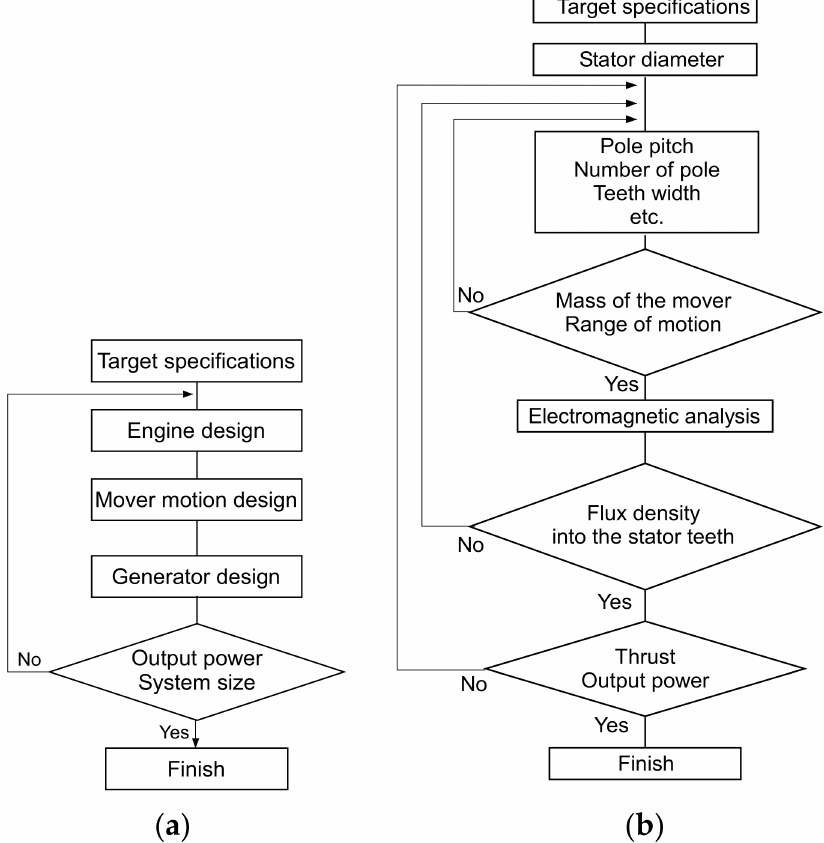
Figure 8. FPEG construction procedure: ( a ) procedure I, ( b ) linear generator